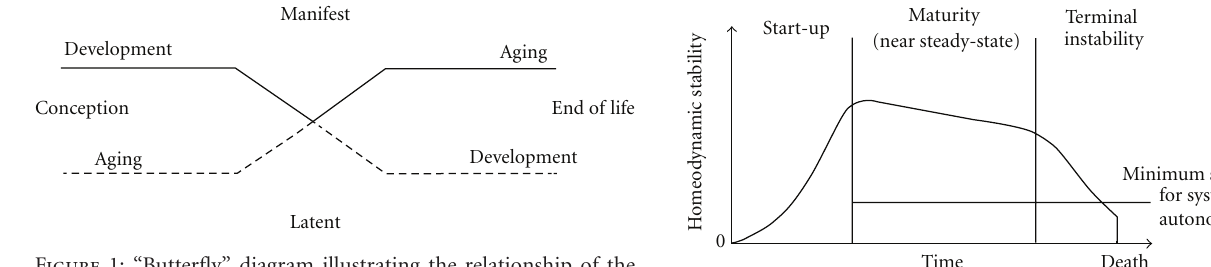
Figure 1: “Butterfly” diagram illustrating the relationship of the processes of development and aging over the course of life [16].